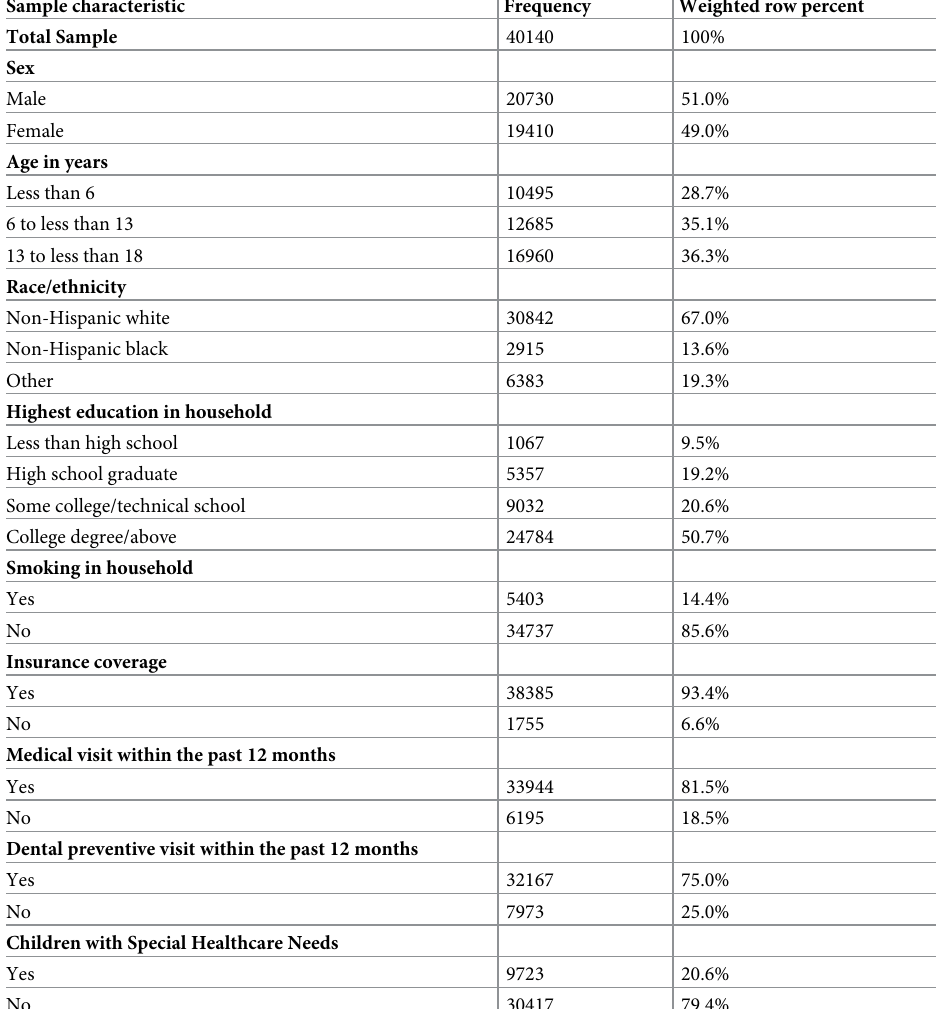
Table 1. Sample characteristics, national survey of children’s health,